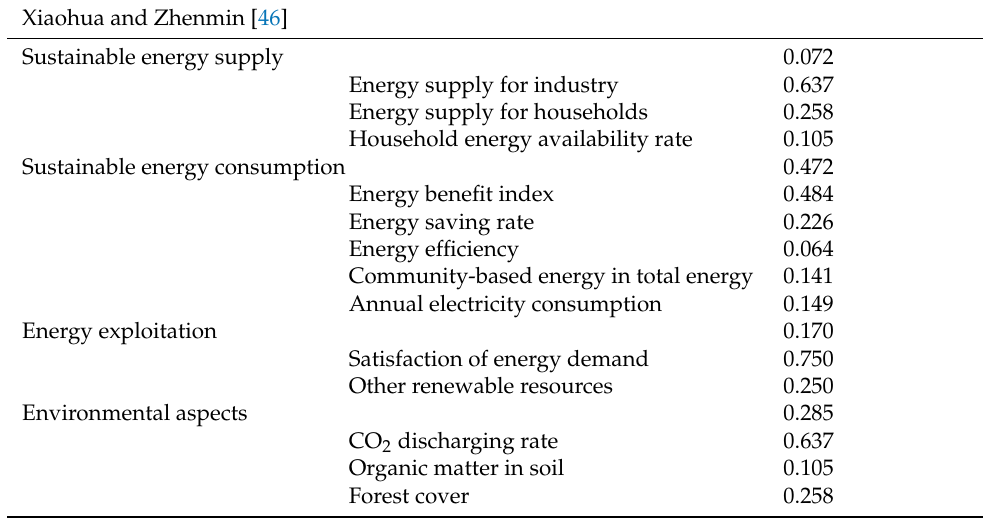
Table 2. Results of AHP analyses of some renewable energy projects. Xiaohua and Zhenmin